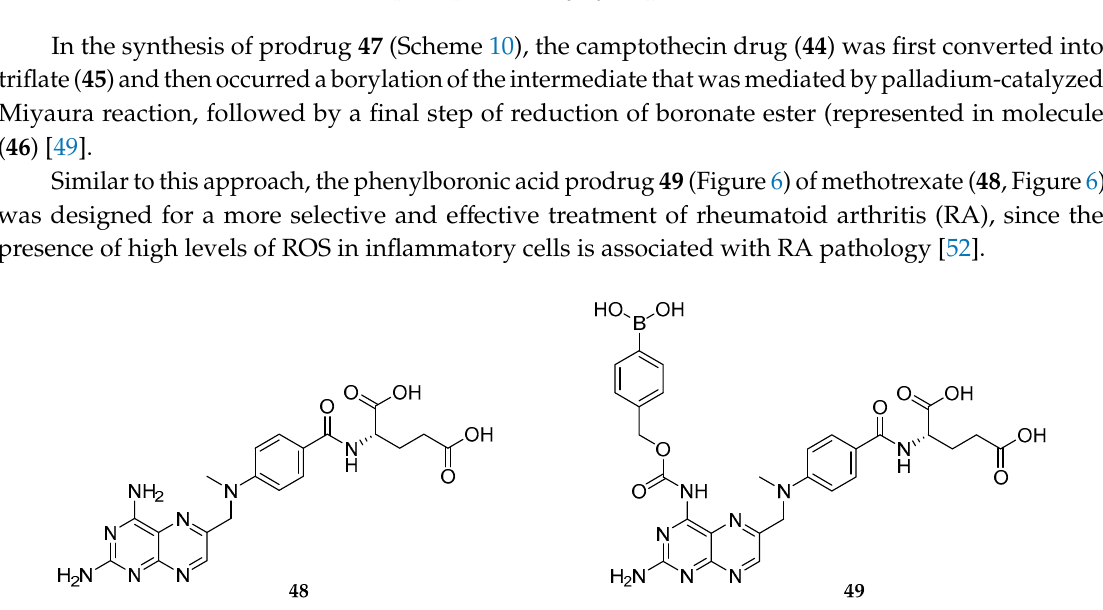
Figure 6. Methotrexate and its phenylboronic acid prodrug ( 48 and 49 , respectively).